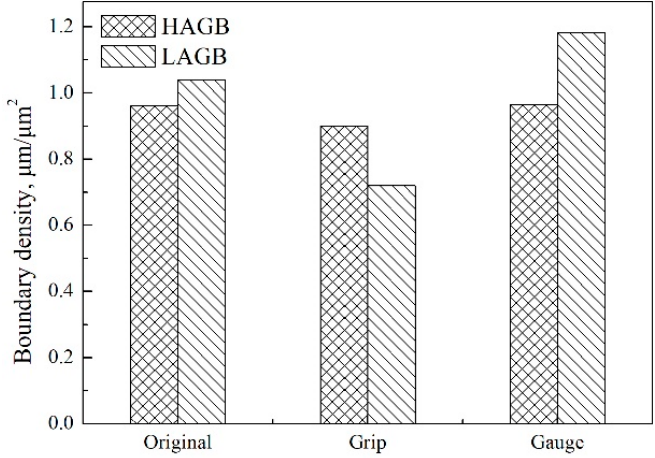
Figure 14. Boundary density of EBSD maps in Figure 11.